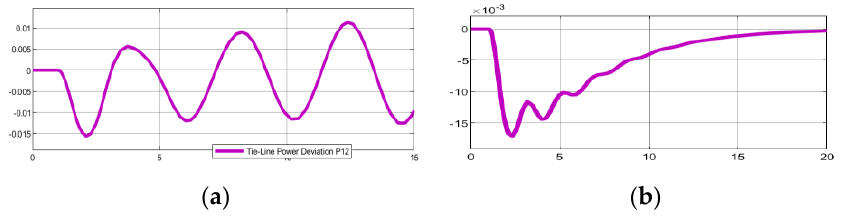
Figure 9. ( a ) Tie-Line Power Deviation P12, Case 1. ( b ) Tie-Line Power Deviation: P12, Case 2.